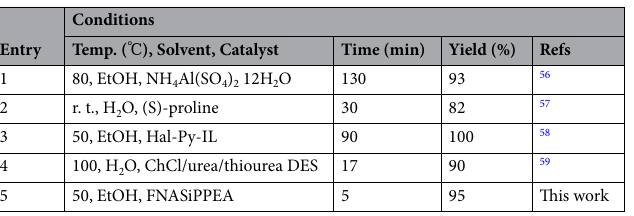
Table 7. Comparison activity of FNASiPPEA with another catalyst for the synthesis of